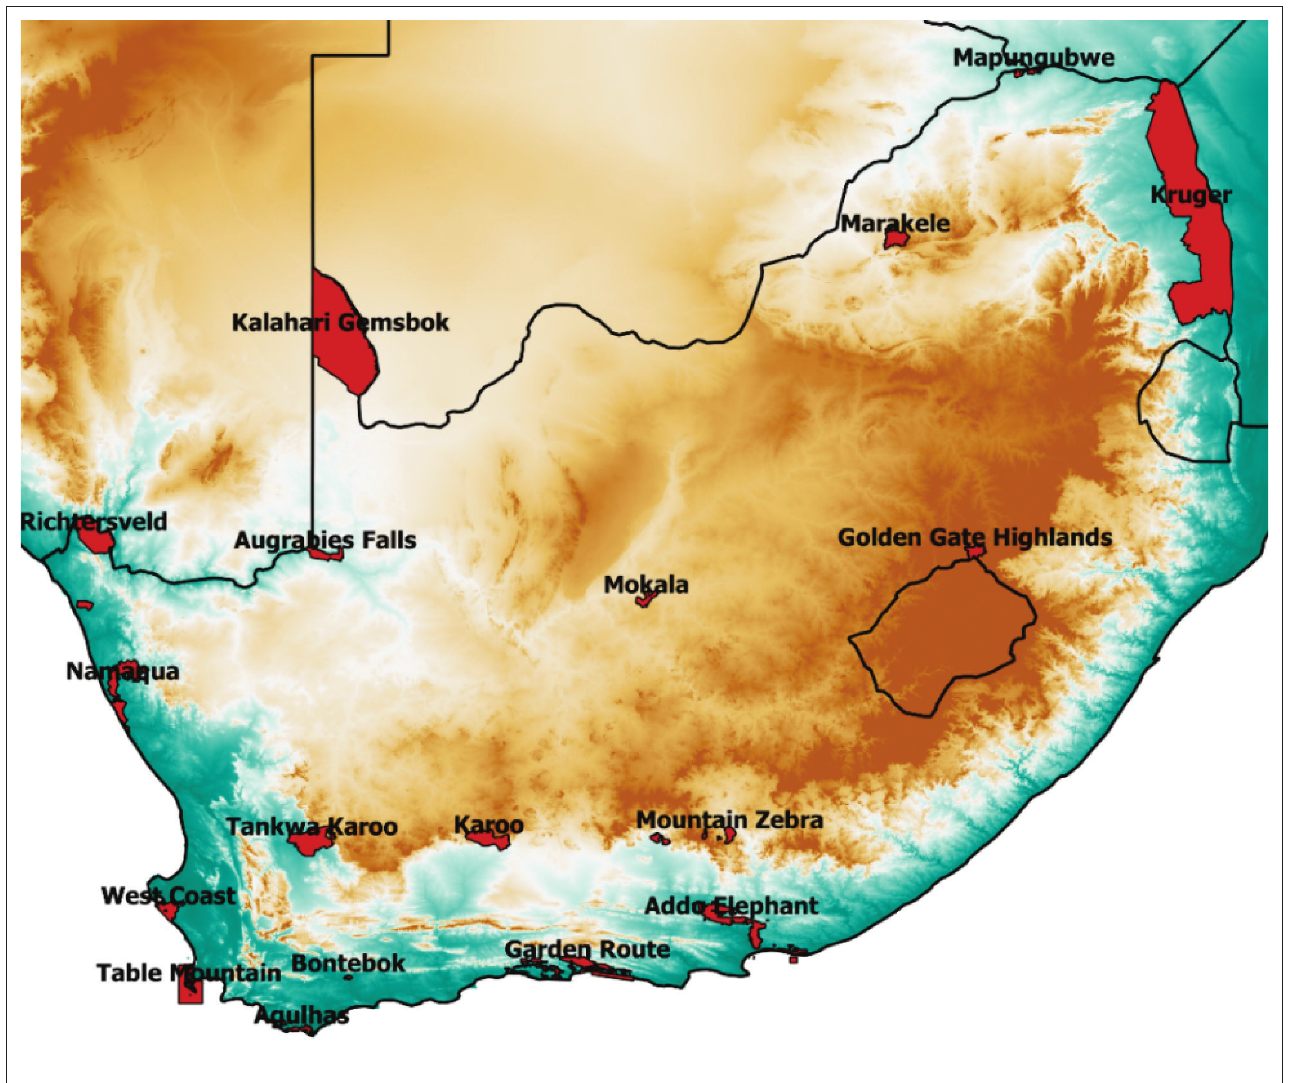
FIGURE 1: Map showing the national parks of South